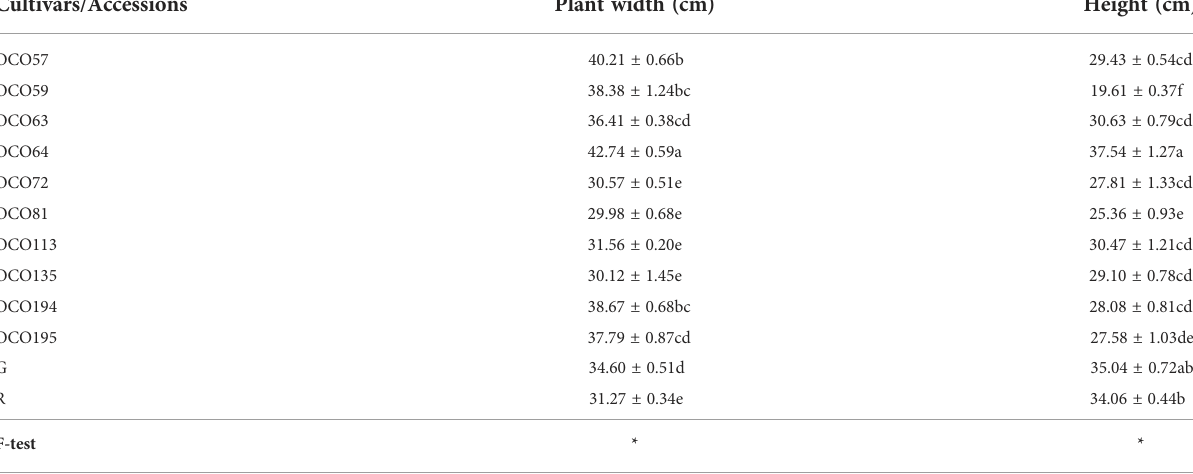
TABLE 1 Growth and plant biomass of 12 cultivars/accessions of Thai holy basil at the fl owering stage (49 DAT) in the hydroponic system under a controlled environment PFAL. Cultivars/Accessions